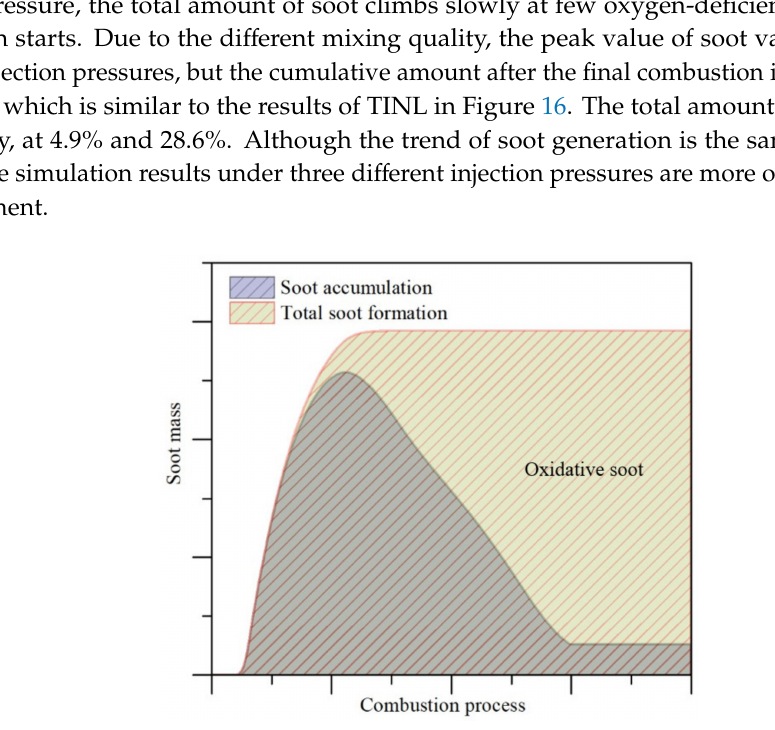
Figure 19. Soot forming and oxidative elimination in